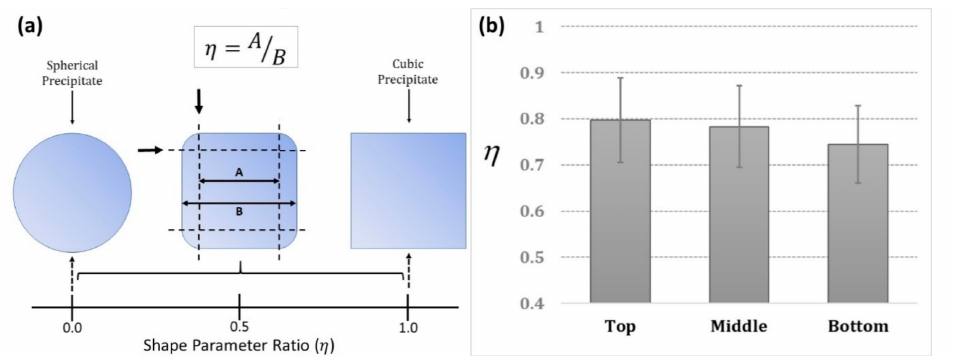
Figure 8. ( a ) Definition of shape parameter ratio ( η ) to quantitatively evaluate γ ’ shapes, and ( b ) average values of η in three sections of aged 4275M72 LDEDed sample. The error bars represent standard deviations of the